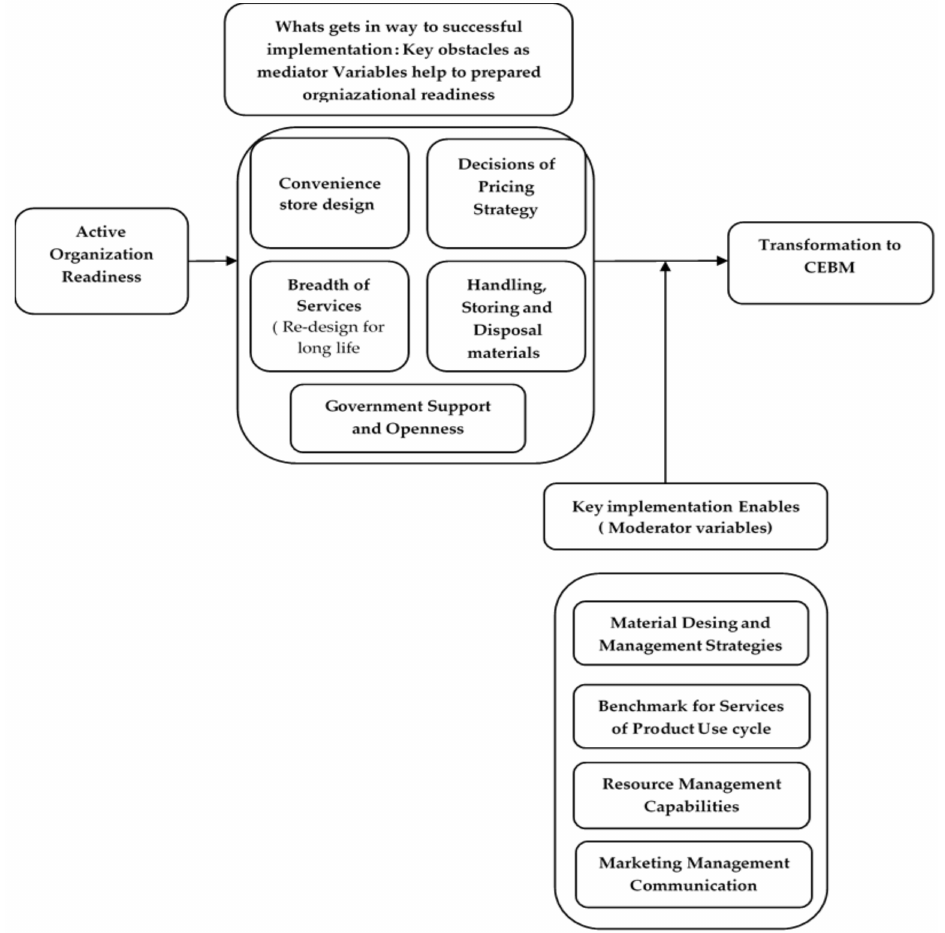
Figure 4. Transitional framework for CEBM